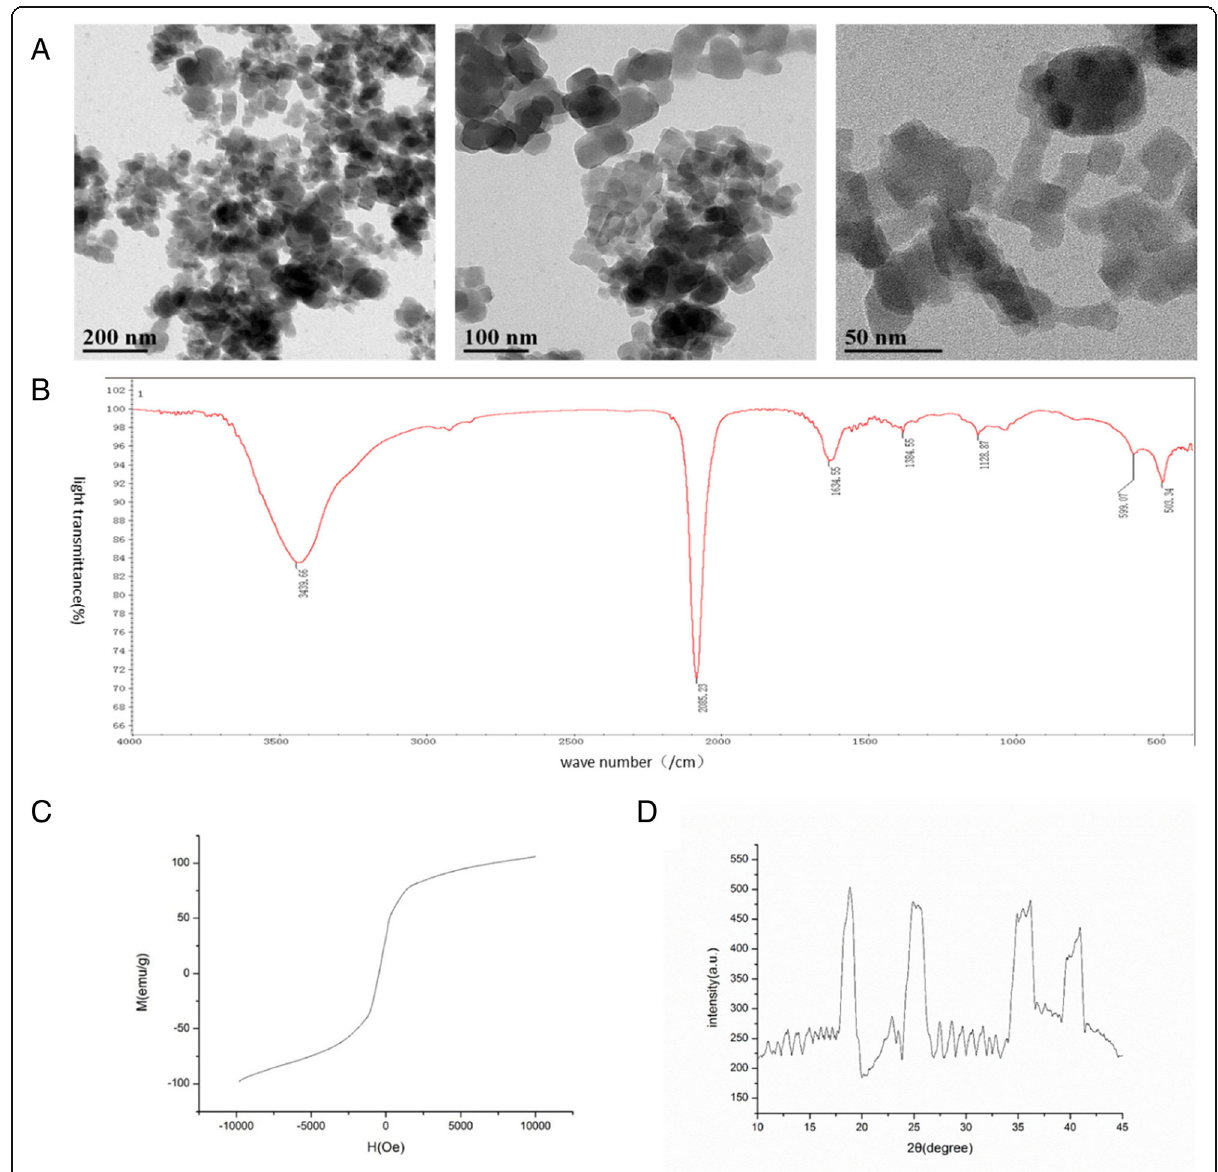
Fig. 1 PBNP characterization. a Morphology of the PBNPs. b UV-vis absorbance spectra of the PBNPs. c Field-dependent magnetization of PBNPs. d XRD pattern of